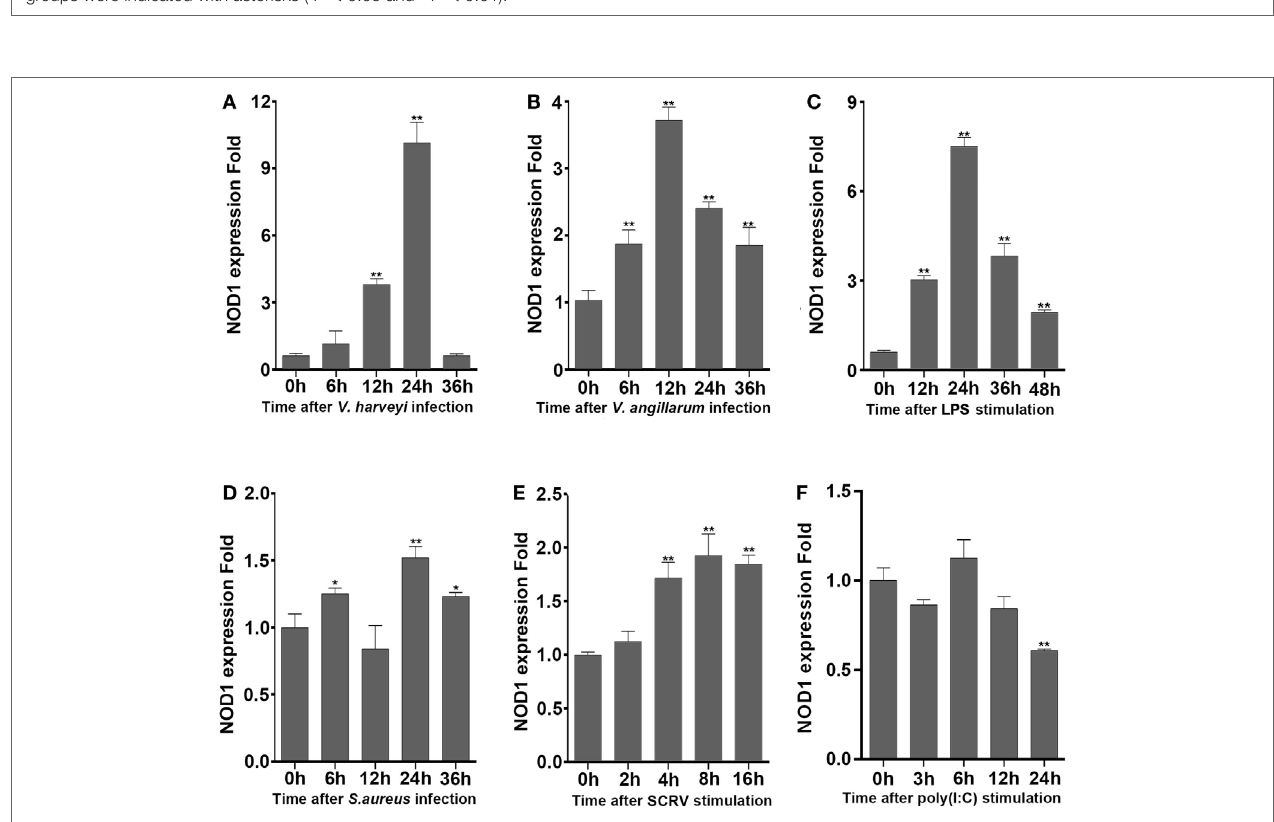
FigUre 2 | NOD1 can respond to the infection of Gram-negative bacteria. The time-course expression profiles of NOD1 were detected using qRT-PCR in miiuy croaker liver infected with V. harvey i (a) , Vibrio anguillarum (B) , lipopolysaccharide (c) , and S. aureus (D) and in miiuy croaker macrophages that were treated with SCRV (e) and poly(I:C) (F) . The expression of β -actin was used as the internal control, and these data were expressed in the form of mean ± SE. The statistically significant differences between control and experience group were indicated with asterisks (* P < 0.05 and ** P < 0.01).